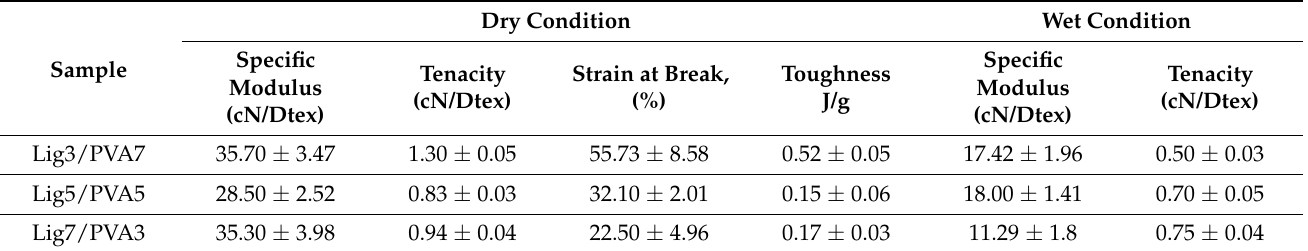
Table 2. Mechanical Properties of Lignin/PVA Fibers.